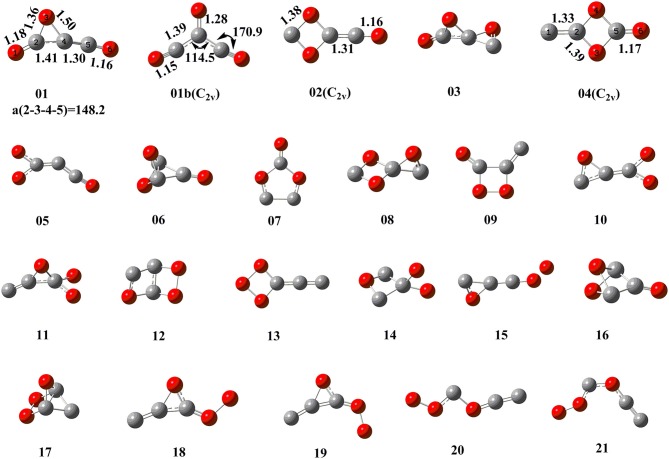
Structural information of singlet C3O3 isomers at the B3LYP/aug-cc-pVTZ level.